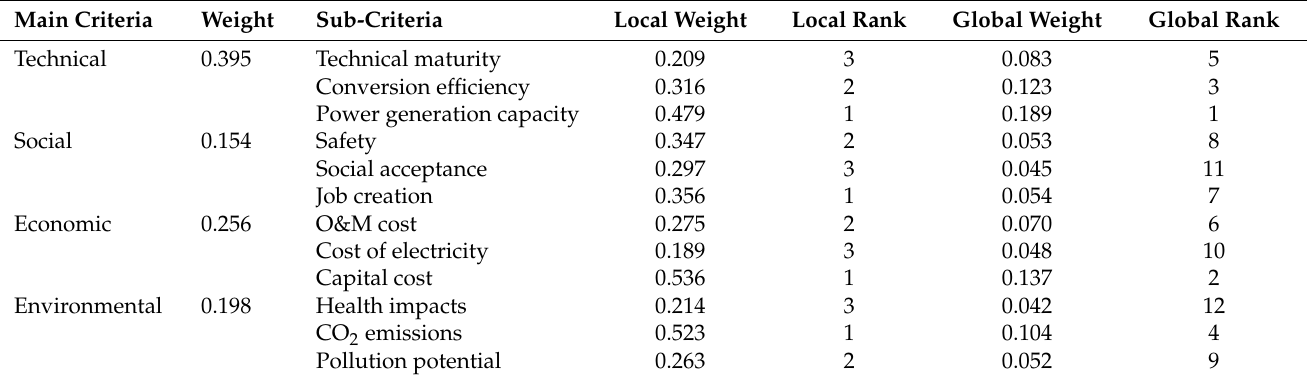
Table 7. Summary of the weights and ranks of the evaluation criteria for WtE technology selection.